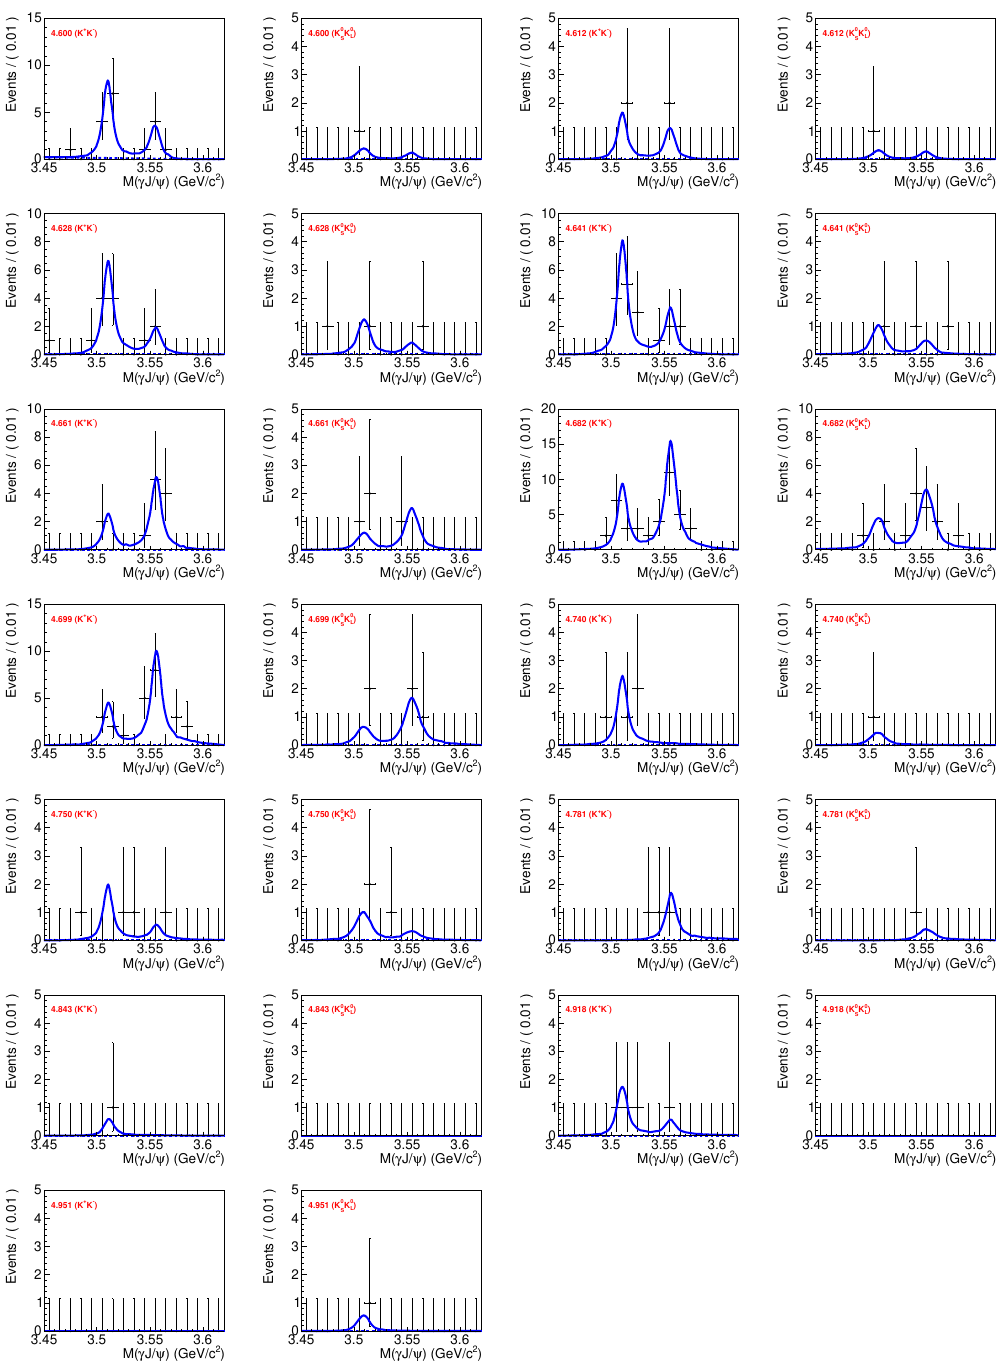
Figure 9 . The simultaneous fit to M ( γJ/ψ ) for φ → K + K − and φ → K 0 4.951 GeV . Dots with error bars are data, blue lines are the fit